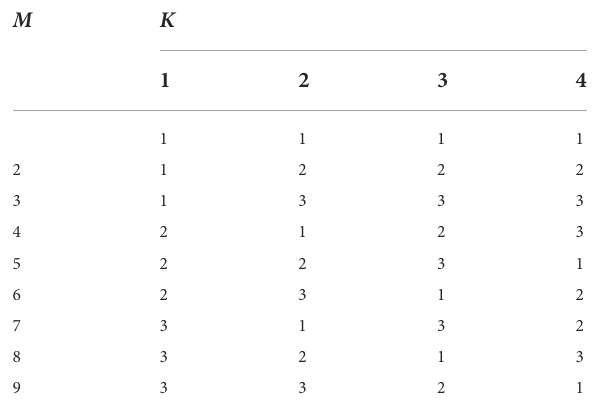
TABLE 1 Orthogonal array of L 9 (3 4